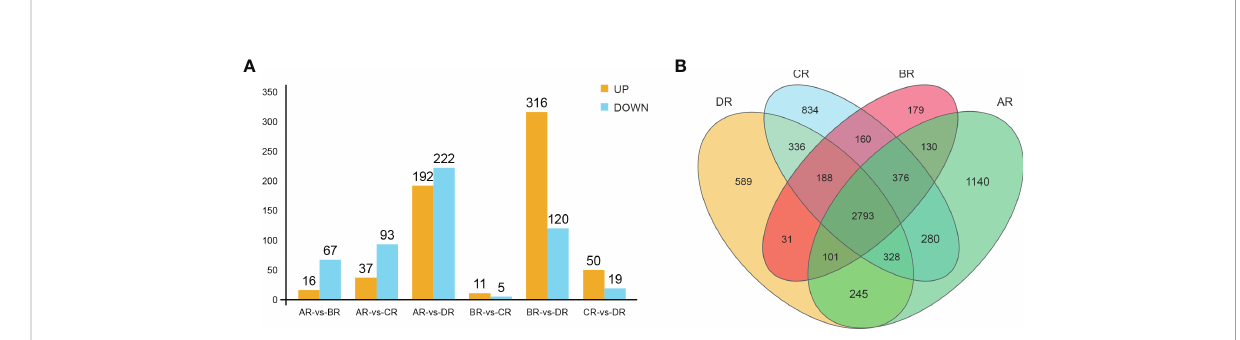
FIGURE 3 Distribution of differentially expressed genes (DEGs) between S. nudus growth stages. (A) DEGs ’ distribution between two groups; (B) Venn diagram of the commonly expressed genes between samples. AR, BR, CR and DR represent four developmental stages: larve, one-quarter of adult, half of adult and adult, respectively.